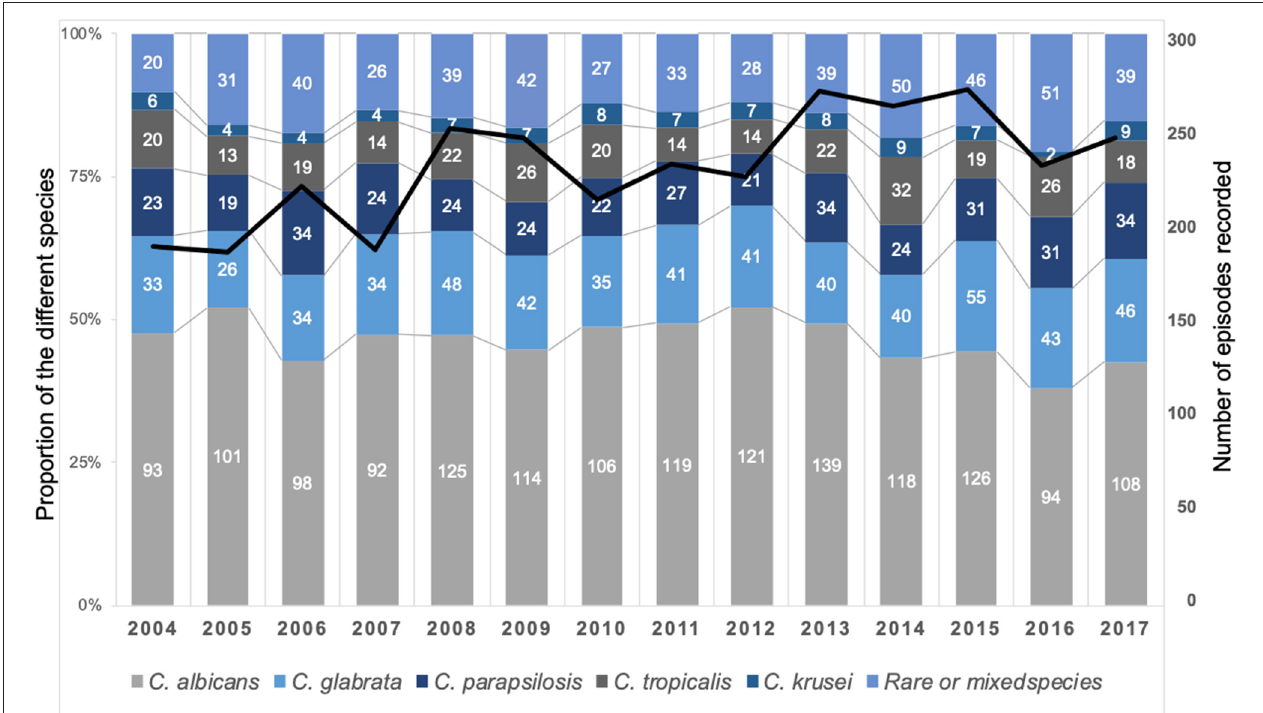
FIGURE 2 | Stable global distribution of species responsible for fungemia during the YEASTS program (Paris area, 2004–2017). Figures in the histograms indicate the number of fungemia due to the five more frequent species, the last category regrouping fungemia due to rare species ( < 2% of isolates) or to mixed species. A total of 3,363 isolates was recovered during 3,257 episodes in 3,092 patients. The black line represents the evolution of the number of episodes over time (linear regression, R ² = 0.5101).